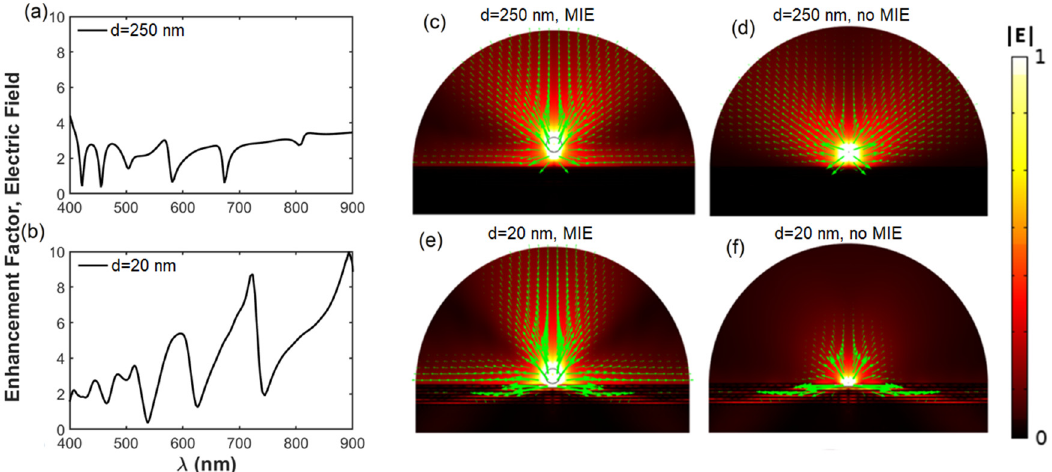
Figure 3 . Effect of the TiO 2 nanoantenna on the enhancement factor and field distribution. Calculation of the enhancement factor spectra with a spacer of ( a ) d = 250 and ( b ) d = 20 nm. Distribution of the normalized electric field |E| of a horizontal (p-polarized) dipole placed at the top of the d = 250 nm spacer layer with ( c ) and without ( d ) the MIE nanoresonator. ( e , f ) corresponds to ( c , d ) but with a thinner spacer layer (d = 20 nm). The point source is considered to emit at λ = 720 nm and the green arrows show the direction and intensity of the energy flux on a logarithmic scale.